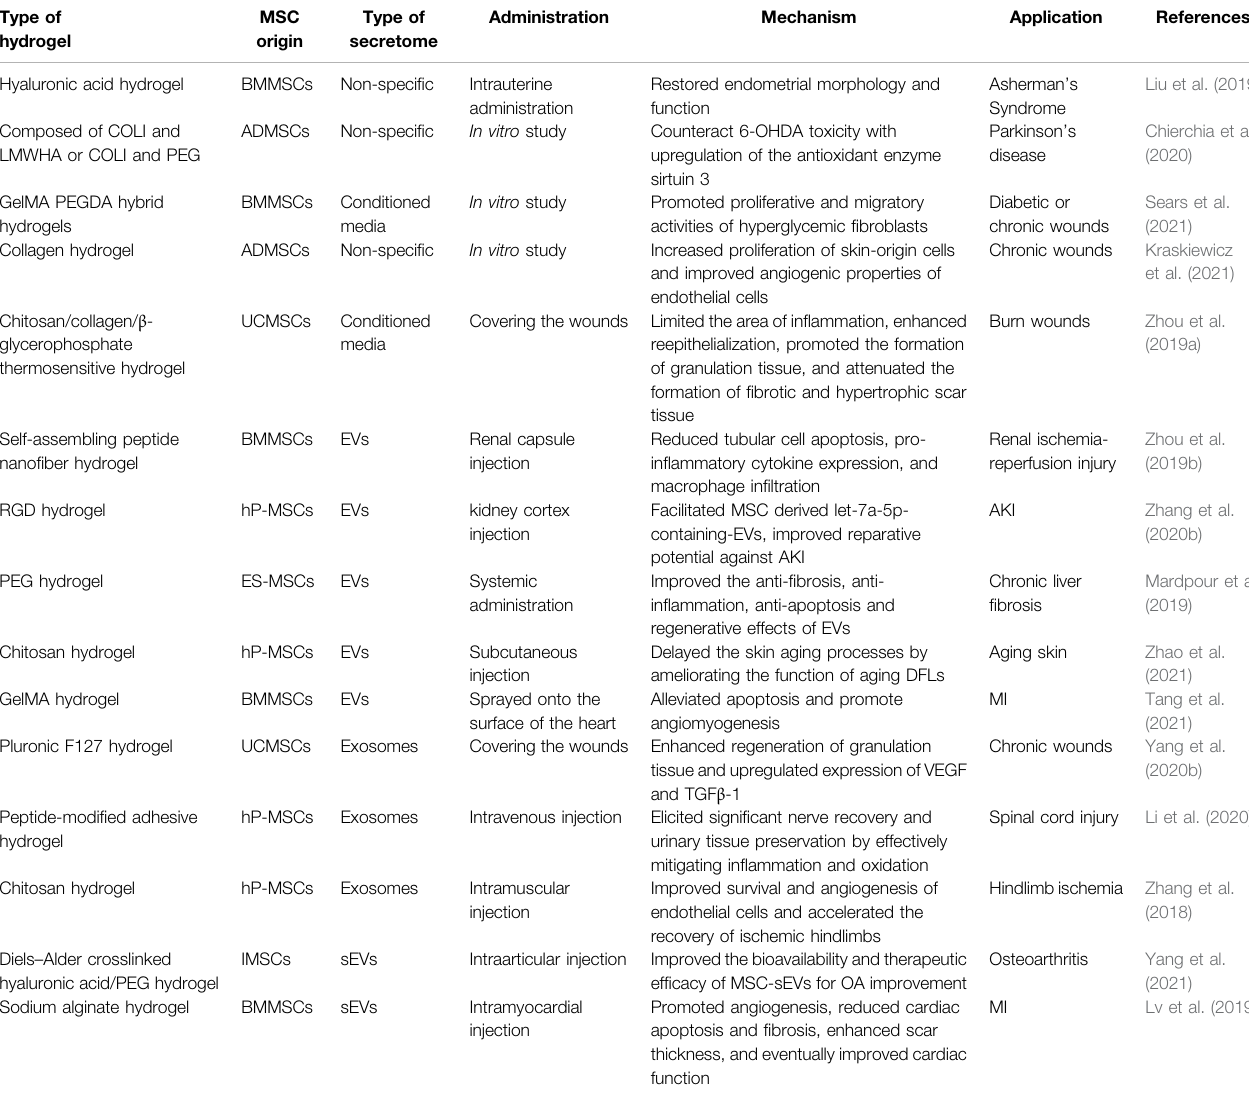
TABLE 2 | Hydrogel-encapsulated MSC secretome in treating